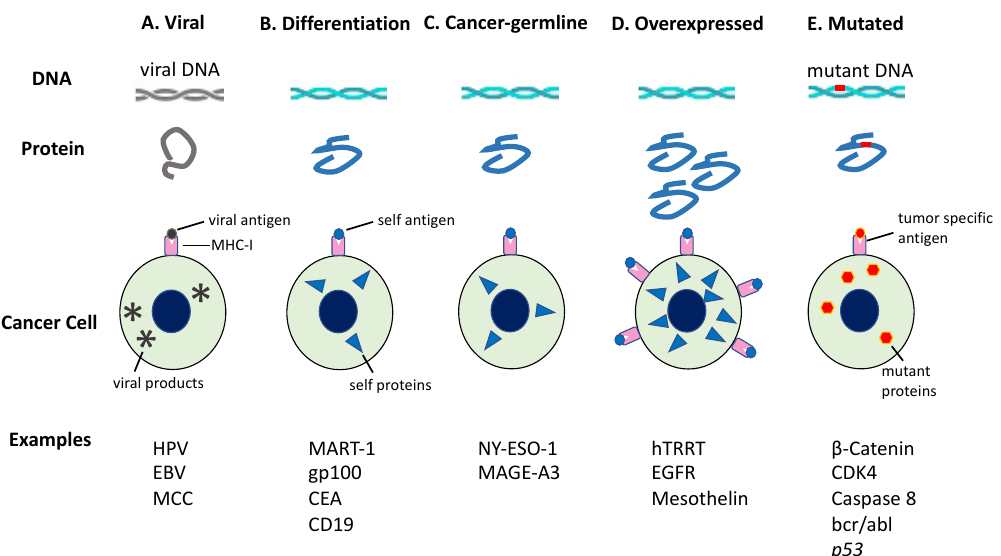
Figure 6. Tumor antigens recognized by immune cells. Tumor antigens are categorized based on the pattern of gene expression. The production of antigenic peptides by cancer cells is illustrated herein. ( A ) Viral antigens are only expressed in virus-infected cells; ( B ) Differentiation antigens are encoded by genes with tissue-specific expression; ( C ) Cancer-germline genes are expressed in tumors or germ cells because of whole-genome demethylation; ( D ) Some genes are overexpressed in tumors owing to increased transcription or gene amplification. The resulting peptides are upregulated on these tumors, but also show a low level of expression in some noncancerous tissues; ( E ) However, mutated genes may yield a mutant peptide (neoantigen), which is recognized as nonself by immune cells. CEA, carcinoembryonic Ag; EGFR, epidermal growth factor receptor; EBV, Epstein-Barr virus; HPV, human papillomavirus; hTERT, human telomerase reverse transcriptase; MAGE-A3, melanoma-associated antigen 3; MART-1, melanoma antigen recognized by T cells-1; MCC, Merkel cell carcinoma. This figure is adapted from our previous article [63].